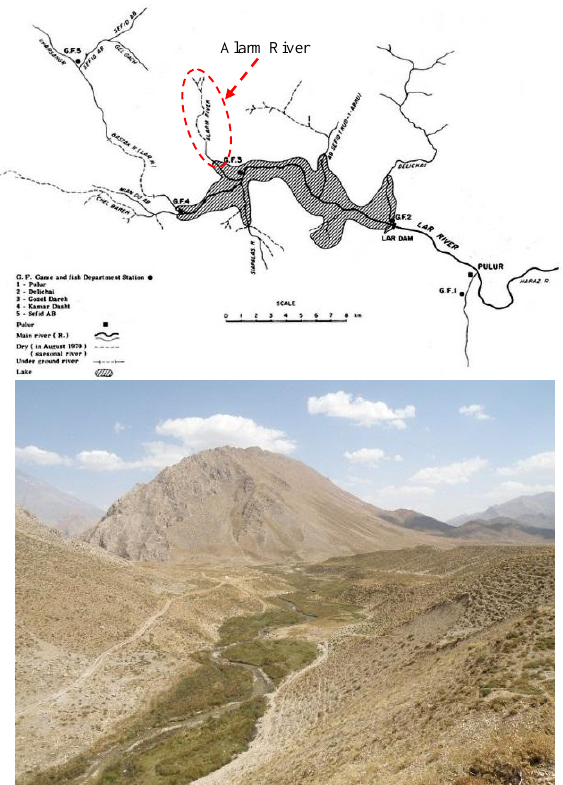
Figure 1. Alarm River, Lar National Park – downstream view